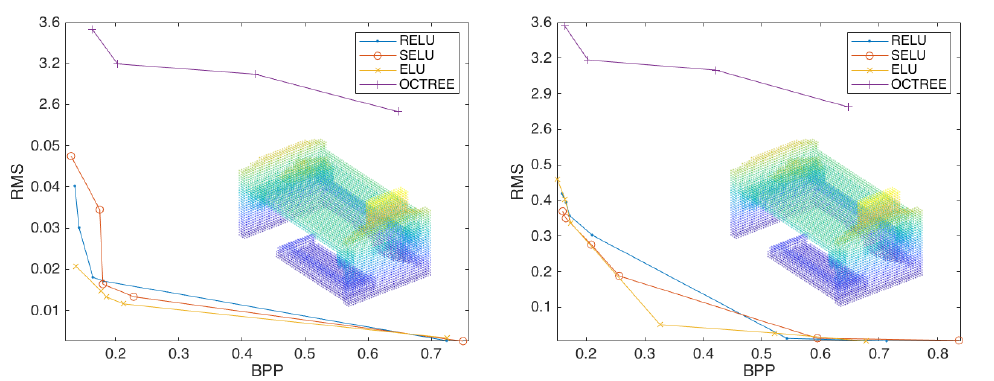
Figure 4. The compression performance of the scheme configured with three layers of convolution and two strides ( left ) and two layers convolution and two strides ( right ), using the activation functions Relu , Selu , and Elu